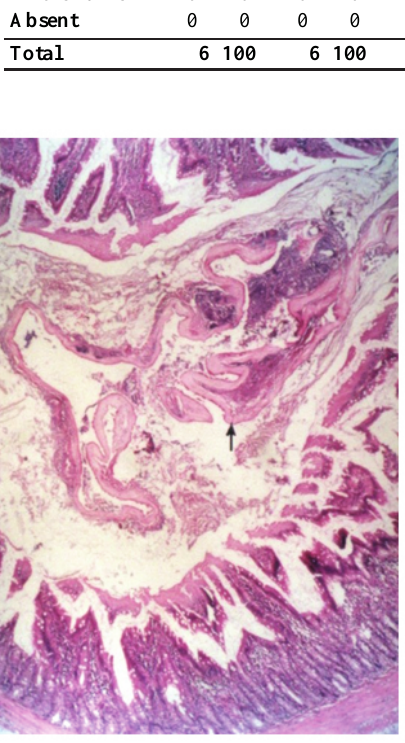
FIGURE 3 - Free amniotic membrane in intestinal lumen